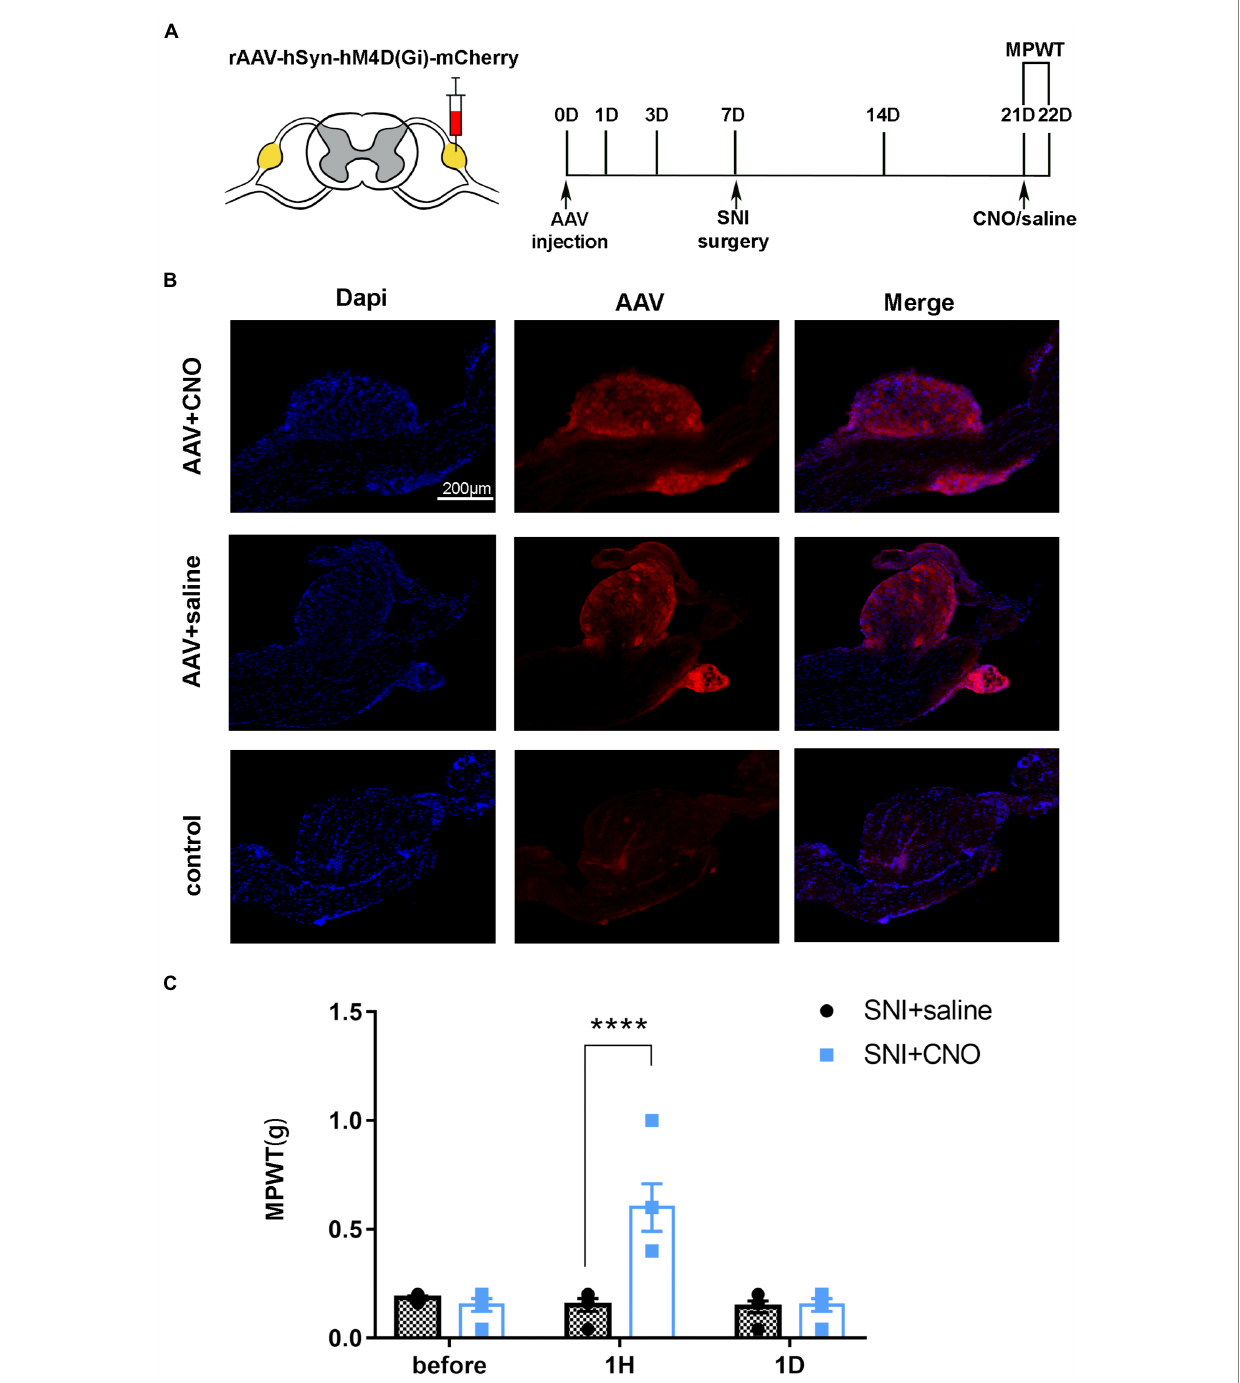
FIGURE 6 DRG may serve as a target for chemogenetic reversal allodynia induced by SNI. (A) The schedule of administrating AAV, saline or CNO, MPWT. (B) AAV virus expressed in the DRG ( n = 5 mice per group). (C) Compared to the saline group, CNO effect reverse allodynia induced by SNI (**** p < 0.0001, n = 5 mice per group), with effect disappearing after 1 day ( p > 0.05, n = 5 mice per